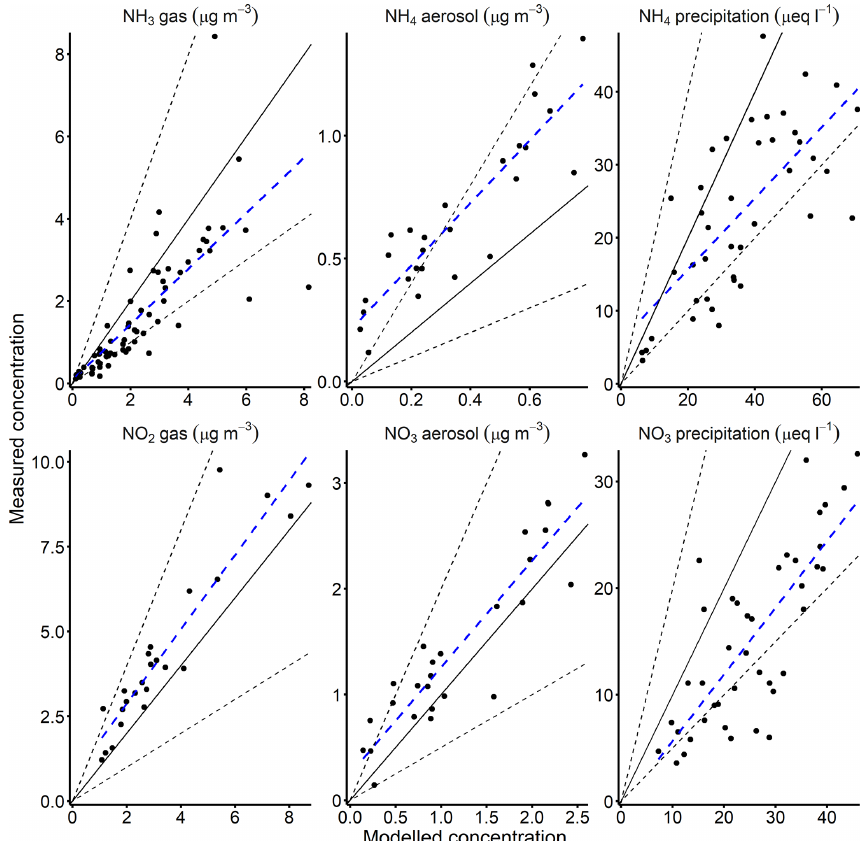
Figure 5. Evaluation of modelled ( x axis) and measured ( y axis) concentrations of six nitrogen compounds in the UK for 2017 (see Table 3 for definitions). The solid black line represents a 1 : 1 relationship, and the dotted lines represent a factor of 2 (FAC2) relationship; the blue dashed lines are linear